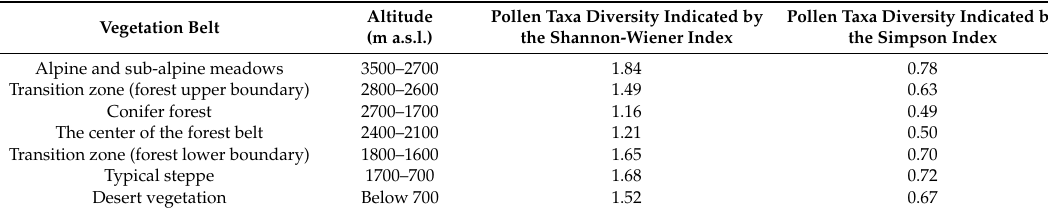
Table 2. Vegetation belt and the pollen taxa diversity in the modern ecosystem.